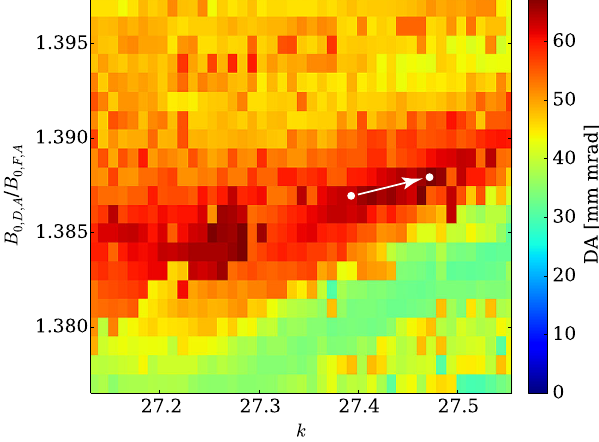
FIG. 6. The DA in the parameter space around the highest optimized value (darker red). The white points and arrow show how the original lattice found by the optimizer is changed (direction of the arrow) to a point in the parameter space with a higher DA.